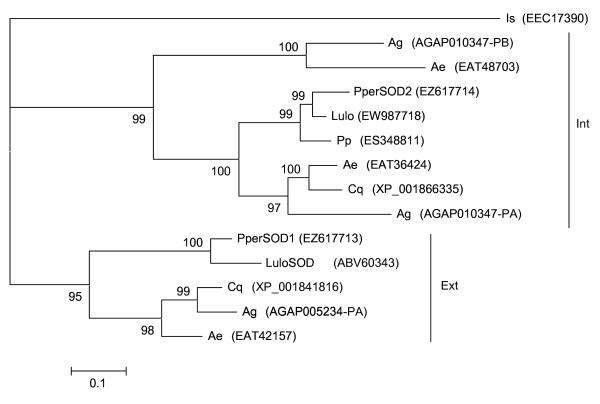
Phylogenetic analysis of superoxide dismutase molecules from Ixodes scapularis (Is), Anopheles gambiae (Ag), Aedes aegypti (Ae), Phlebotomus perniciosus (Pper), Lutzomyia longipalpis (Lulo), Phlebotomus papatasi (Pp) and Culex quinquefasciatus (Cq). GenBank accession numbers are given in parentheses, the clades are labelled with the respective localization based on SignalP prediction (Int: intracellular, Ext: extracellular) and node support is indicated by the bootstrap values.